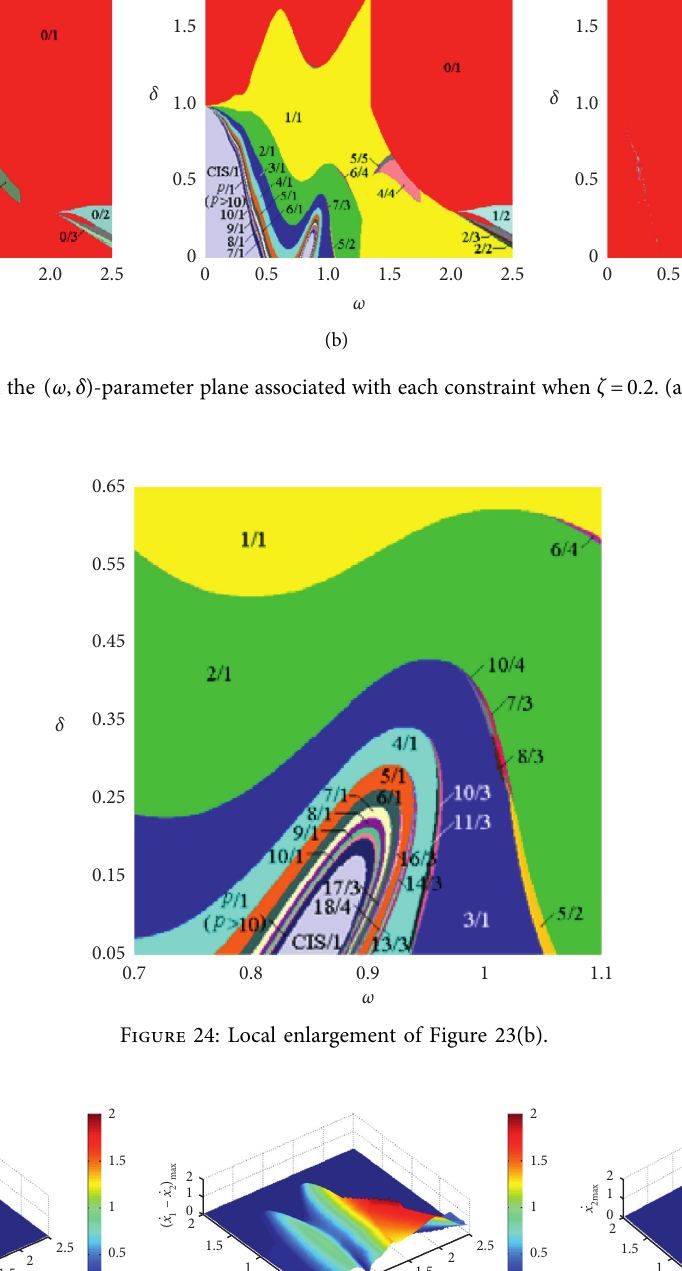
Figure 25: Three-dimensional surface diagrams of the maximum impact velocity of the system associated with each constraint when ζ � 0.2. (a) Constraint A 1 ; (b) constraint A 12 ; (c) constraint A 2